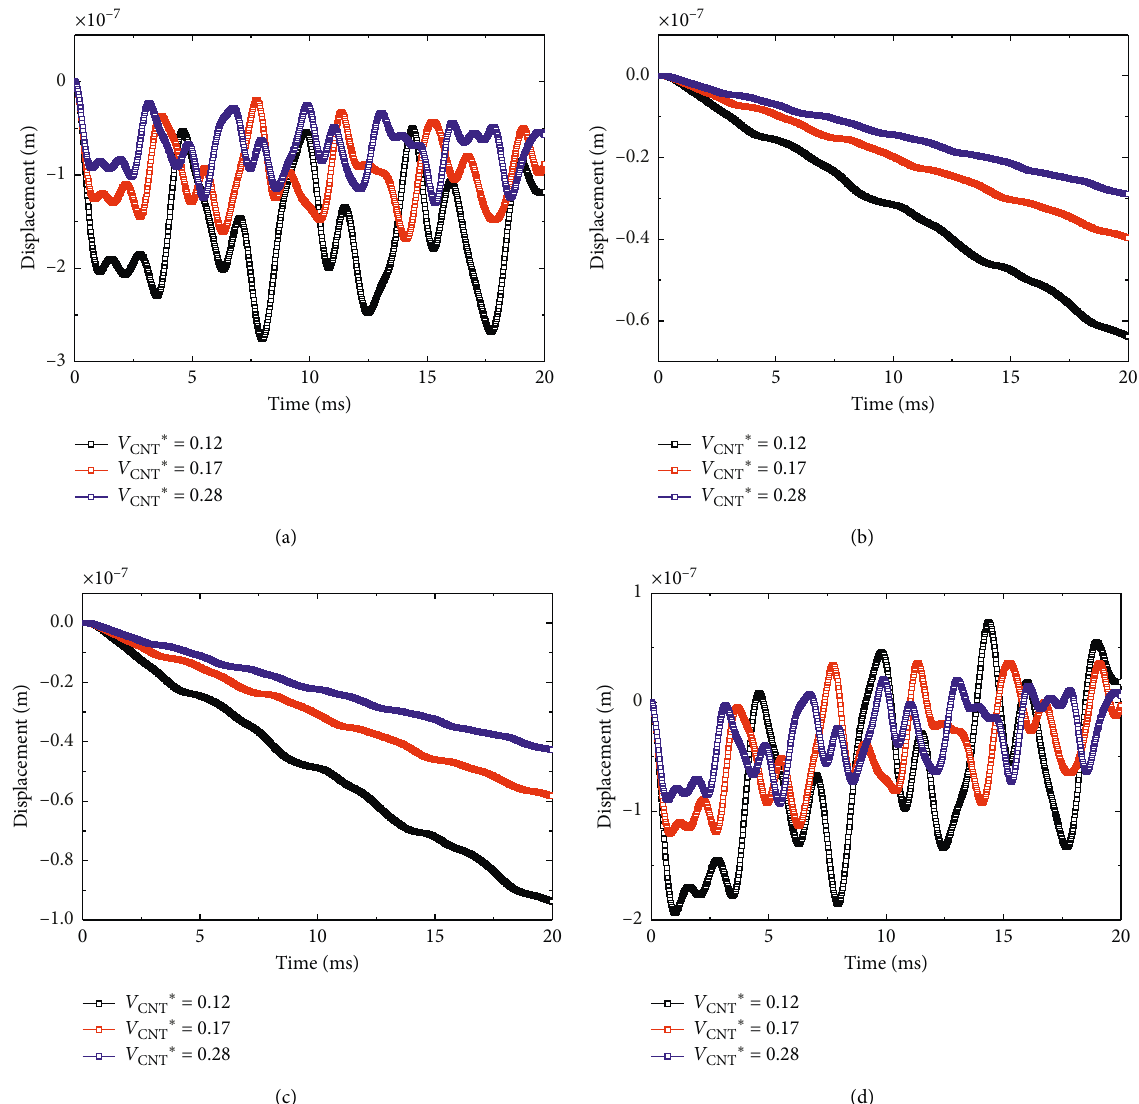
Figure 18: The displacement response of stepped FGPE plate under different pulse types. (a) Rectangular pulse. (b) Triangular pulse. (c) Half-sine pulse. (d) Exponential